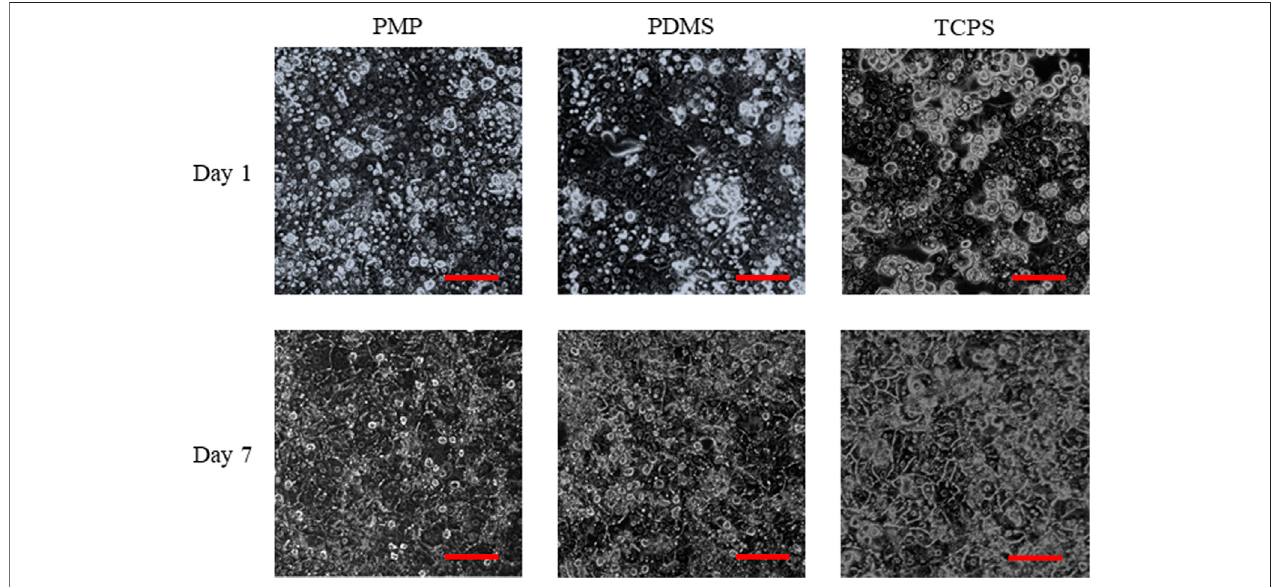
FIGURE 3 | Morphologies of rat primary hepatocytes. Scale bars represent 100 μ m.